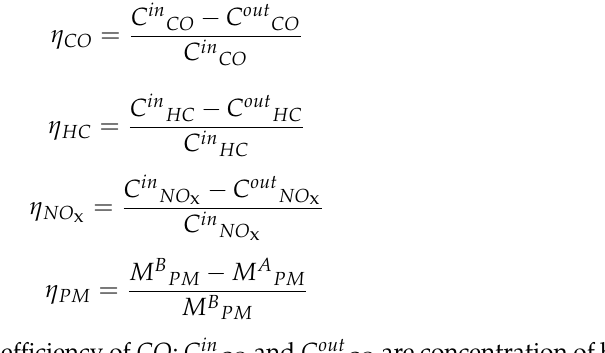
Table 1. Concentration of simulated exhaust gas